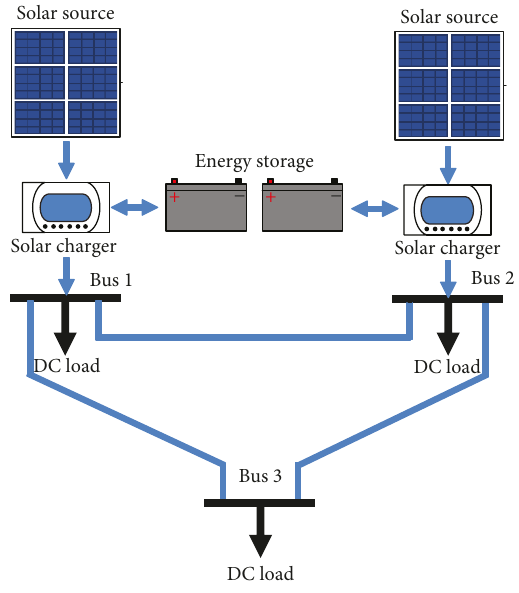
Figure 3: DC microgrid connected to multiple